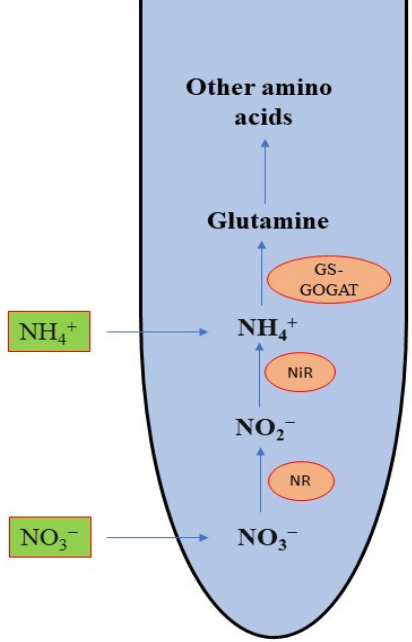
Figure 12. Schematic diagram showing the role of (NR) nitrate reductase in N assimilation by plants. NO 3 − is converted into NO 2 − by NR (nitrate reductase). NO 2 − is further converted into NH 4+ by NiR (nitrite reductase). NH 4+ is converted into amino acids by GS-GOGAT (glutamine synthetase, GS; glutamate-2-oxoglutarate aminotransferase).